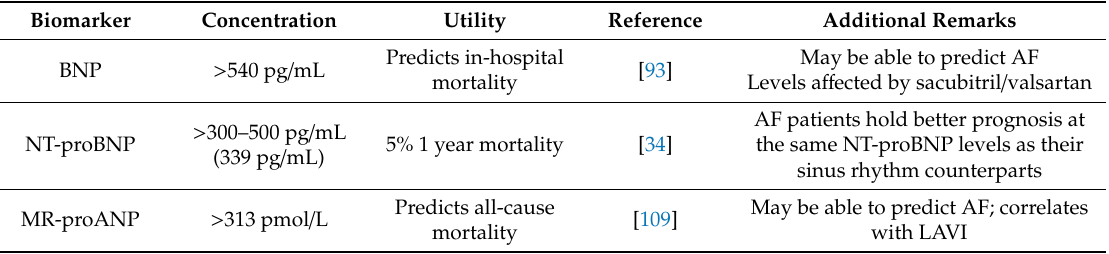
Table 5. Prognostic values of natriuretic peptides in heart failure with preserved ejection fraction